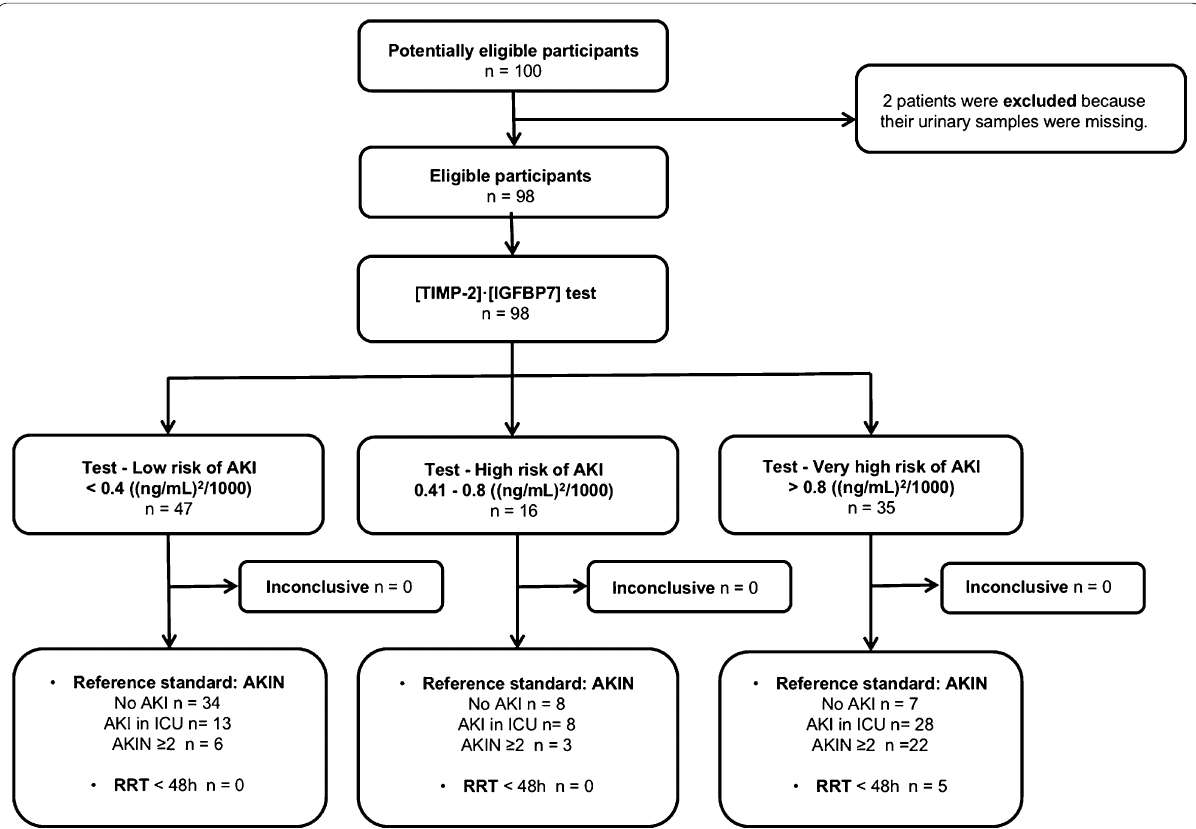
Fig. 1 Diagram of [TIMP‑2] [IGFBP7] index to predict AKI, study enrolment and ·